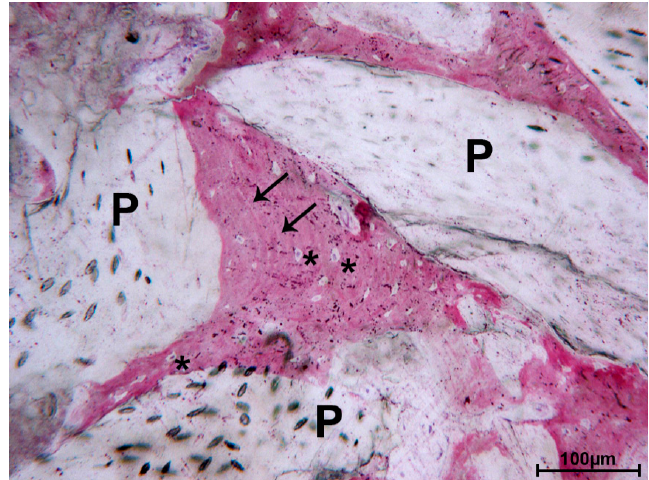
Figure 3. DEBM . Regenerated lamellar bone (black arrows), perfectly filling the inter-DEBM particle (P) gaps. Many osteocyte lacunae were present (*). Toluidine blue and acid fuchsin, original magnification 100×.